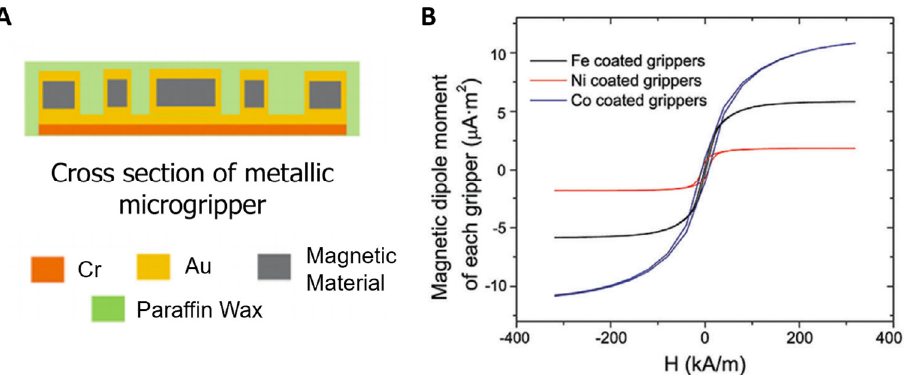
Figure 6. Magnetic response in metallic thermogrippers. ( A ) As seen in the cross-section of a metallic thermoresponsive microgripper, magnetic material is embedded within the Cr-Au bilayer to elicit a magnetic response. ( B ) The magnetic dipole moments of soft robotic microgrippers with various magnetic metals layers were compared. Microgrippers with cobalt had the greatest magnetic dipole moment of 11 µ A m 2 . Adapted with permission from Ref. [17]. Copyright 2021.